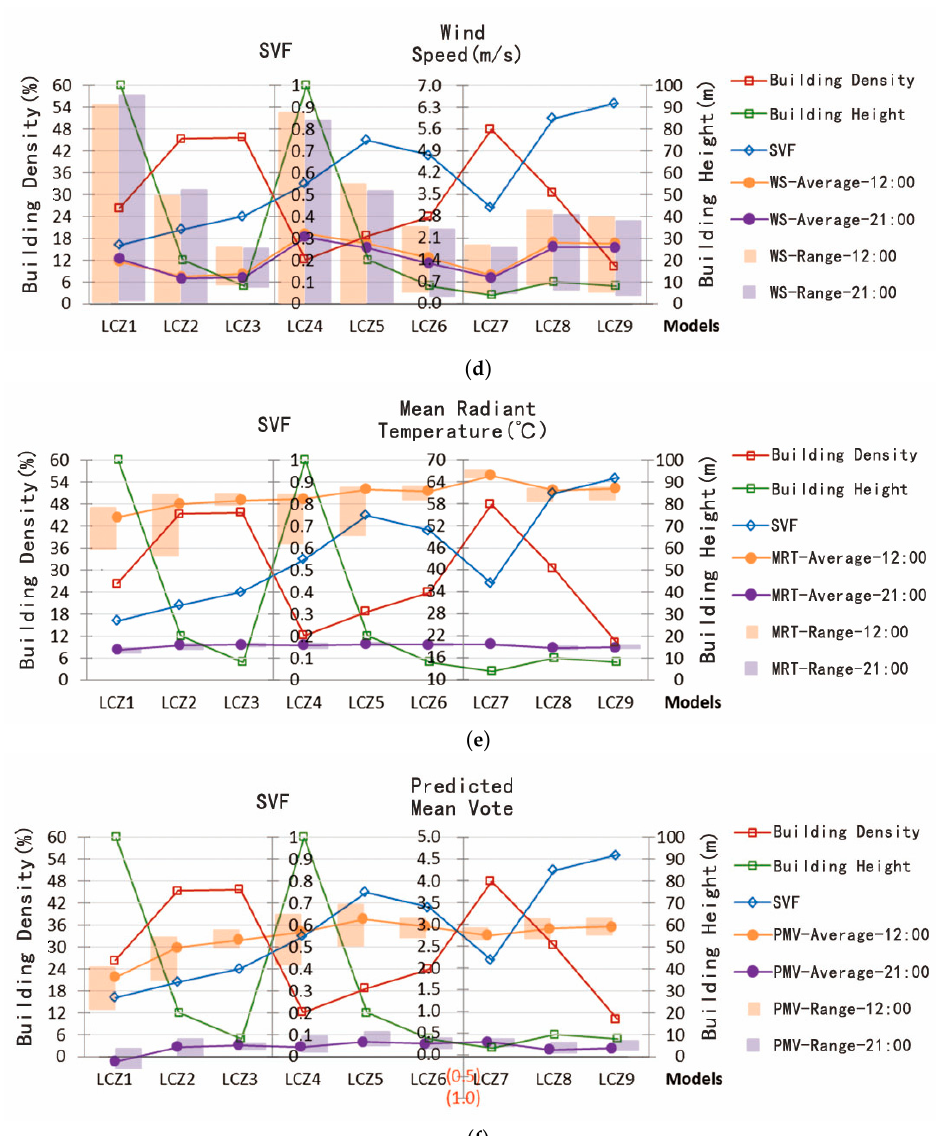
Figure 9. Comparison between SVF and microclimate and thermal comfort indices for all the nine models. ( a ) air temperature, ( b ) relative humidity, ( c ) surface temperature, ( d ) wind speed, ( e ) mean radiant temperature, ( f ) predicted mean vote.